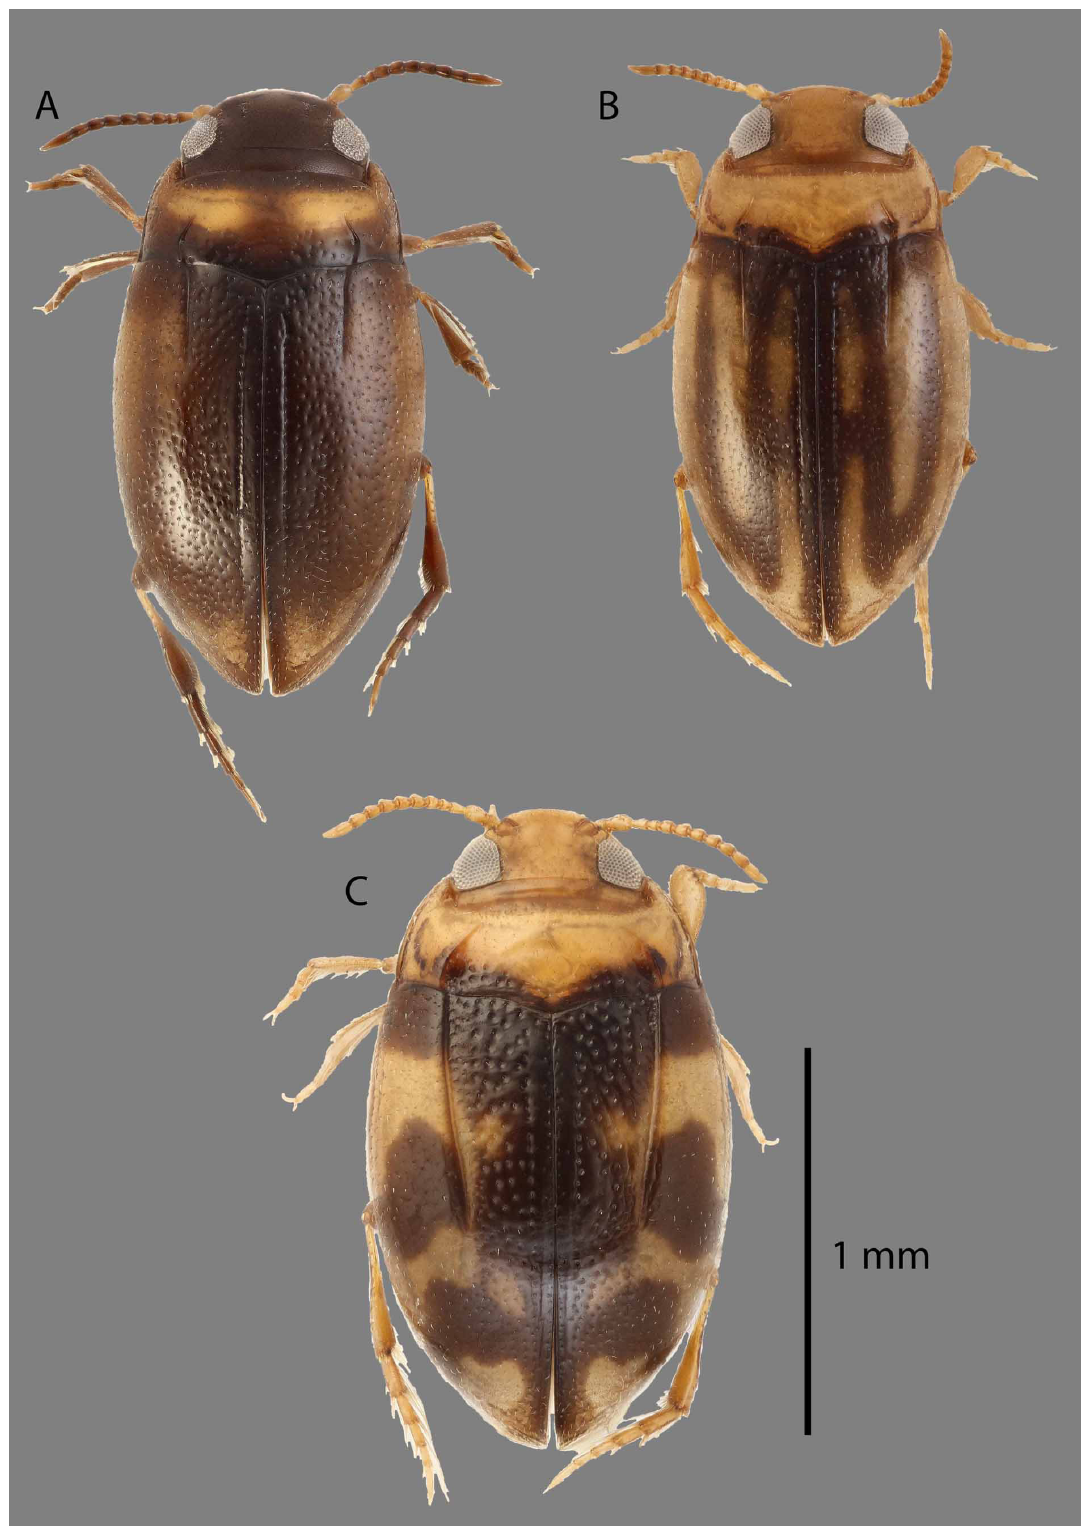
Fig. 2. Habitus photographs of Malagasy species of Bidessus Sharp, 1882. A . B. nesioticus Guignot, 1956 (NHRS-JLKB000025031). B . B. perexiguus Kolbe, 1883 (NHRS-JLKB000025029). C . B. longistriga Régimbart, 1895